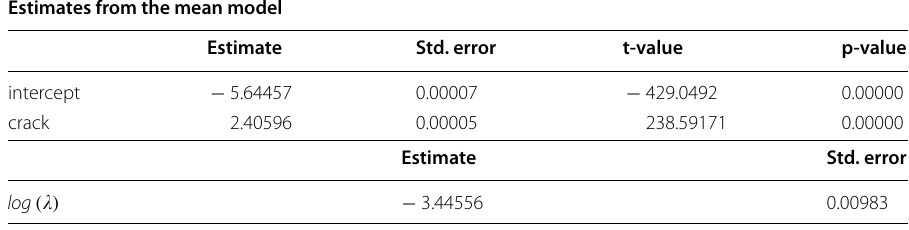
Table 2 Results of DHGLM for crack growth data Estimates from the mean model Estimate Std. error t‑value p‑value intercept Estimate Std. error log ( (cid:31) ) 3.44556 − Estimates from the dispersion model Estimate Std. error Intercept